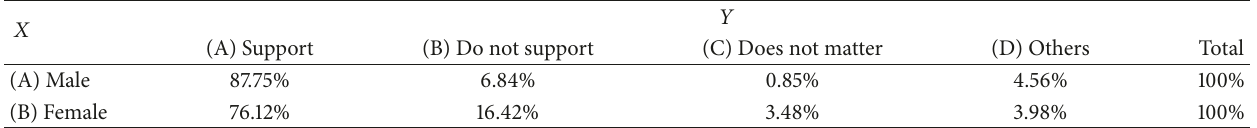
Table 12: Cross-analysis between gender and attitudes toward countdown signals.